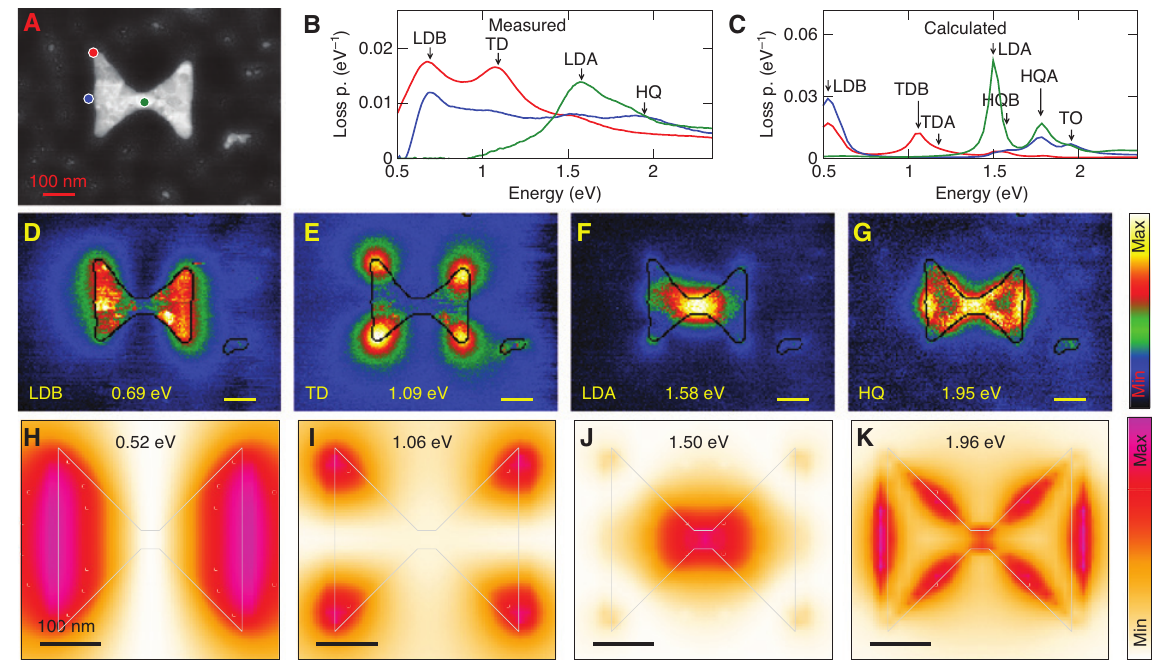
Figure 3: Diabolo antenna with the wing length L = 150 nm. (A) HAADF image. (B, C) EEL spectra recorded at specific points indicated by colour spots in panel A (the spectrum displayed by a specific colour corresponds to the spot of the same colour): measured (B), calculated (C). The labels of the peaks and modes are explained in the text. (D–G) Experimental energy-filtered maps of the loss intensity for (D) longitudinal dipolar bonding mode, (E) transverse dipolar mode, (F) longitudinal dipolar antibonding mode, (G) hexapolar–quadrupolar mode. (H–K) Calculated loss intensity at the energy of (H) longitudinal dipolar bonding mode, (I) transverse dipolar mode, (J) longitudinal dipolar antibonding mode, (K) hexapolar–quadrupolar mode. Mode energies are indicated. Contours of the antennas are shown by black (experiment) or grey (calculations) lines. The length of the scale bars is 100